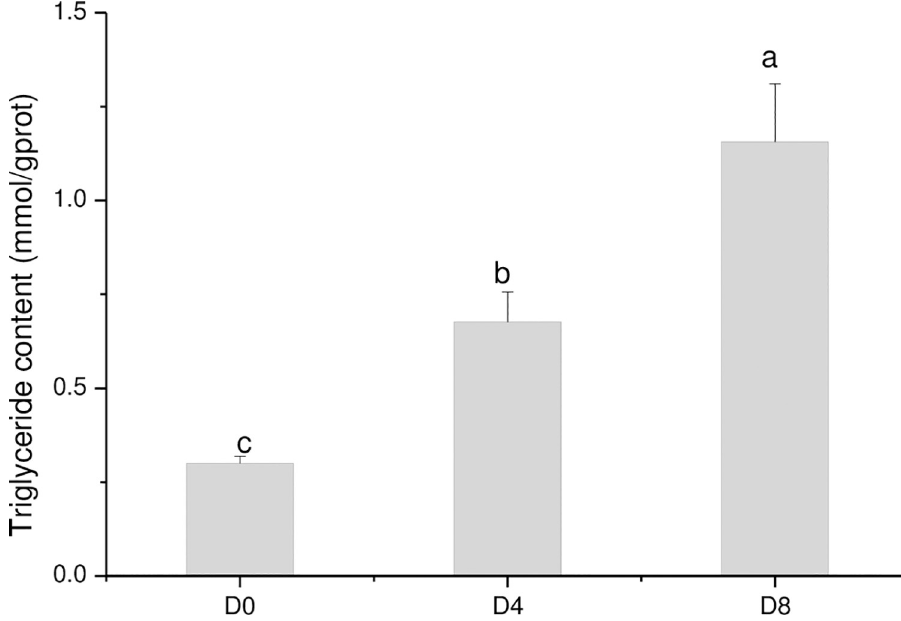
Fig 2. Triglyceride content at different stages of differentiation was measured using a triglycerol assay kit. https://doi.org/10.1371/journal.pone.0261293.g002 (61.1%) were longer than 5,000 bp (Fig 5F). The majority (49.7%) of novel lncRNAs was found in intergene region lncRNAs (“lincRNAs”), and the minority (21.8%) was antisense (Fig 5D). However, most (94.97%) novel circRNAs were exons, and only a small quantity were inter- genic (2.42%) and intron circRNAs (2.61%) (Fig 5E). Gene ontology and KEGG analysis of DE genes between D4 and D0 Between D4 and D0, we found significant GO terms for DE mRNA related to metabolic pro- cesses, primary metabolic processes, cellular component organization, intracellular processes, cytoplasmic parts, catalytic activity, and protein binding (S5(A) Fig). Based on DE lncRNAs with their trans-acting mRNAs, regulation of multicellular organisms, regulation of transport, immune system processes, membrane parts, intrinsic and integral membranes, receptor bind- ing, long-chain fatty acid binding, fatty acid binding, carboxylic acid binding, and monocar- boxylic acid binding were significantly enriched through GO analysis between D4 and D0 (S5 (B) Fig). Based on DE lncRNAs with their cis-acting mRNAs, nucleus and intracellular parts were significantly enriched through GO analysis between D4 and D0 (S5(C) Fig). Significantly enriched GO terms were primarily involved in biological regulation, cellular and metabolic processes, growth, cell parts, binding, catalytic activity, enzyme regulator activity, and nucleic Table 1. The number of DE mRNAs, lncRNAs, and circRNAs in the D4 vs. D0, D8 vs. D0, and D8 vs. D4 comparisons. Groups Upregulated mRNAs Downregulated mRNAs Upregulated lncRNAs Downregulated lncRNAs Upregulated circRNAs Downregulated